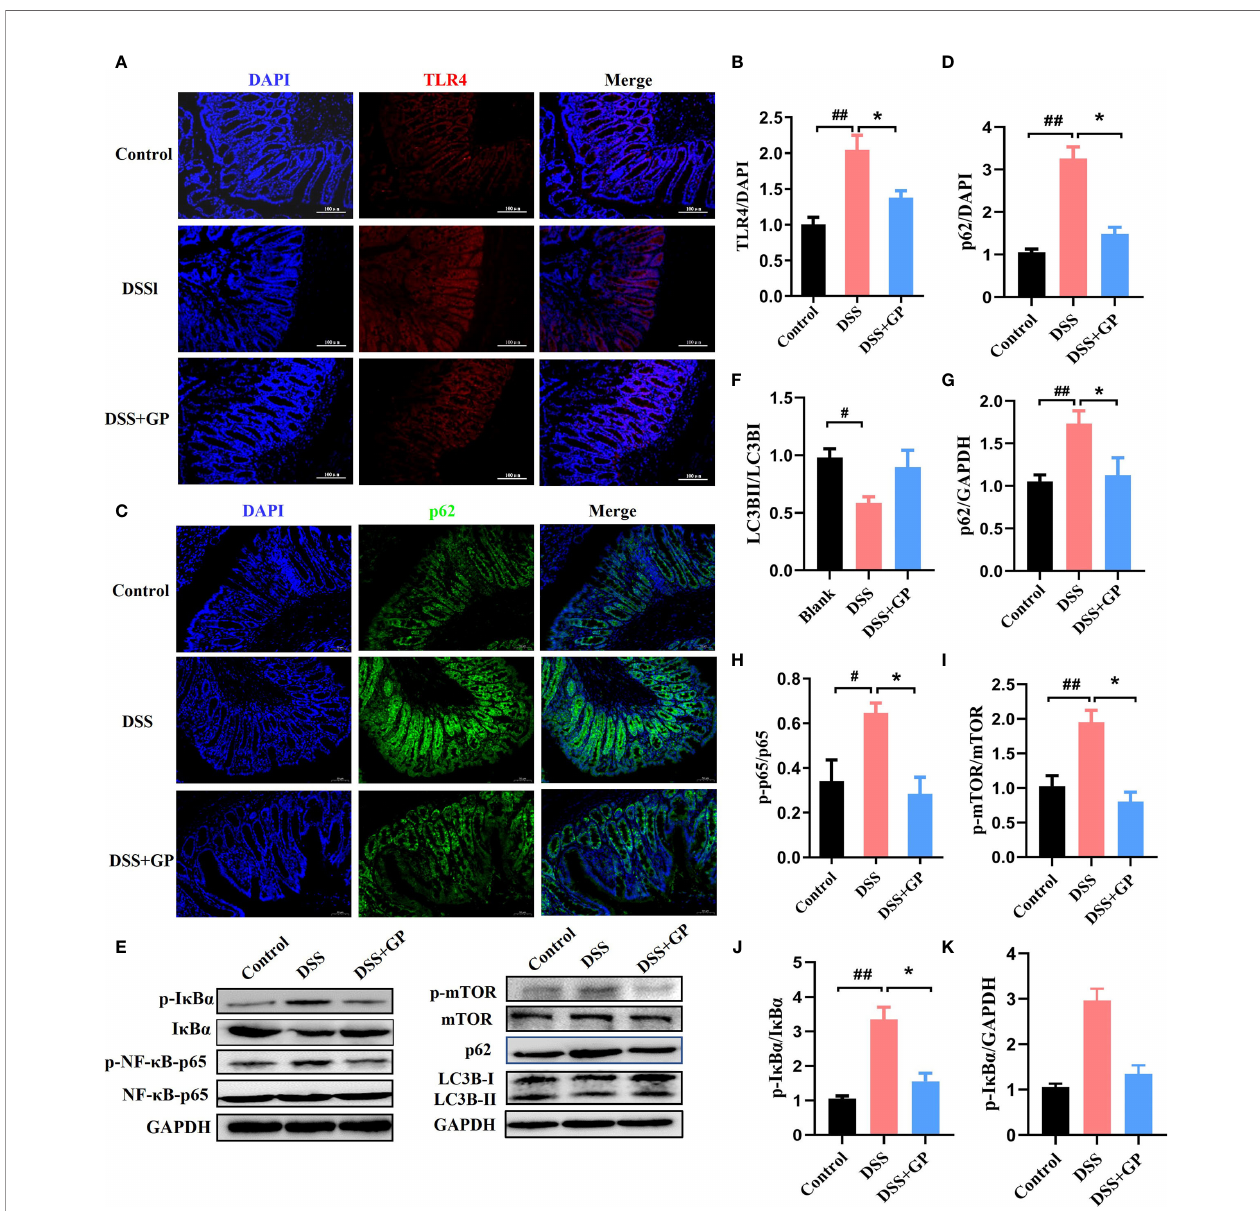
FIGURE 4 | GP inhibits in fl ammation via TLR4 pathway andactivates mTOR dependent autophagy inDSS-induced colitis in vivo . (A, C) Immuno fl uorescence for TLR4 and p62 was performed on colon sections. (B, D) The expressionsof TLR4 and p62 werecalculated relative to DAPI staining from three independent experiments. (E) The expression of autophagy-related and in fl ammation-related proteins measuredby western blot. (F – K) The expressionsof proteins were quanti fi ed bythe ratio of phosphorylated protein/total proteinand total amount protein/GAPDH. Alldata shown are representative of 3 independent experiments. Barsingraphs reprActivatedTLR4 directly triggersthe phosphorylation of mTOR. With the increase ofTLR4 in the DSS group, the phosphorylated mTOR was upregulated followed bythe dysfunction of autophagy. To investigate whether autophagy was impaired inDSS-induced intestinal in fl ammation,the expression of autophagy-related proteins (includingLC3B, p62, and phosphorylated mTOR)were evaluated by immuno fl uorescence and Westernblot. Compared with the control group, the expression ofp62, a cargo protein degraded inside autolysosomes, was upregulated after DSS stimulation,indicating the inhibition ofautophagy. Defective autophagywas further con fi rmed bythe decrease in LC3BII/LC3BI when compared with the control group. Autophagy was recovered to a normal level after treatment with GP, indicatedby decreased p62 and increased LC3BII/LC3BI levels. These results demonstratedthat GP relieved intestinal in fl ammation bypromoting mTOR-dependent autophagyand blocking the in fl ammatory cascade. Bars in graphs represent mean ± SD, # P < 0.05, ## P < 0.01 VS Control group; *P < 0.05 VS DSS